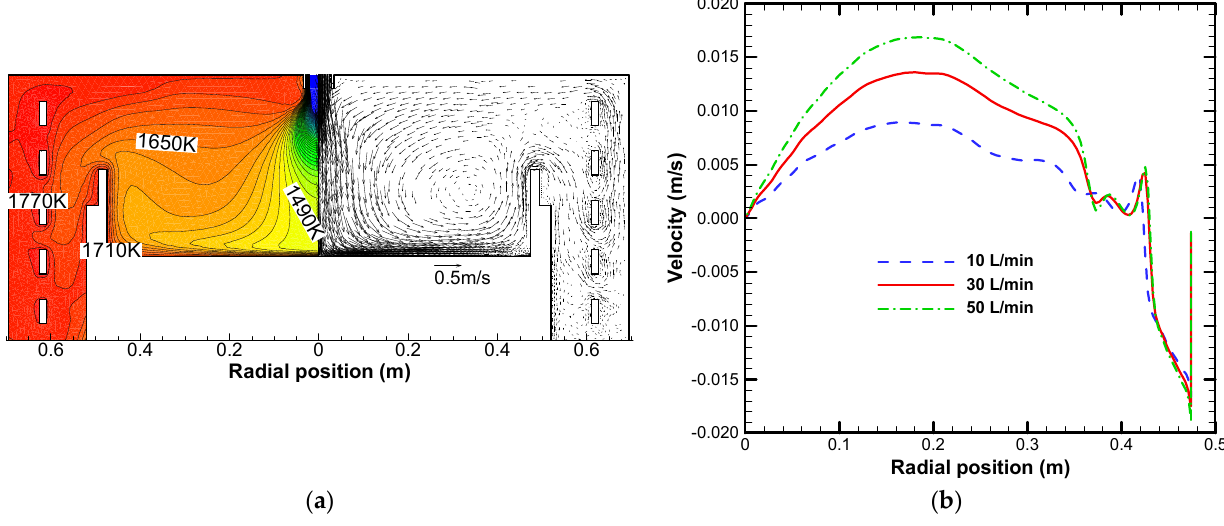
Figure 2. Local temperature ( ∆ T = 20 K) and velocity fields for the flow rate of 30 L/min at S.F. (solidification fraction) = 50% ( a ) and velocity along the melt–gas surface under different flow rates ( b ).